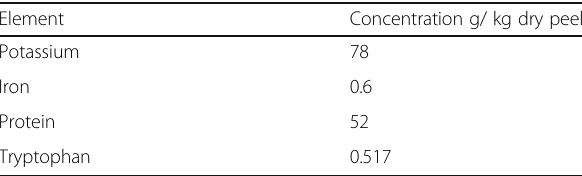
Table 2 Composition of banana peel extract using alkaline extraction Element